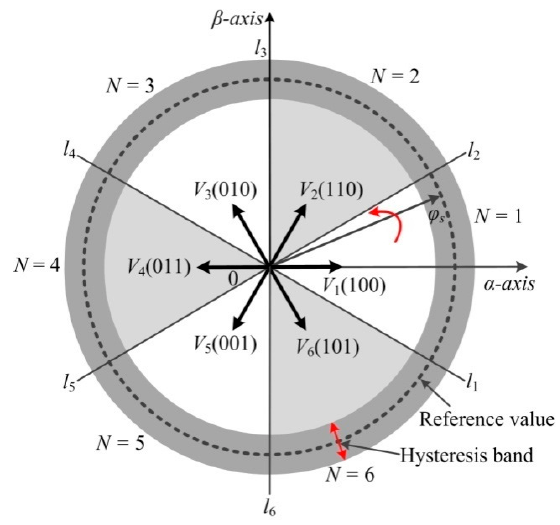
Figure 1. Active vectors in DTC system.